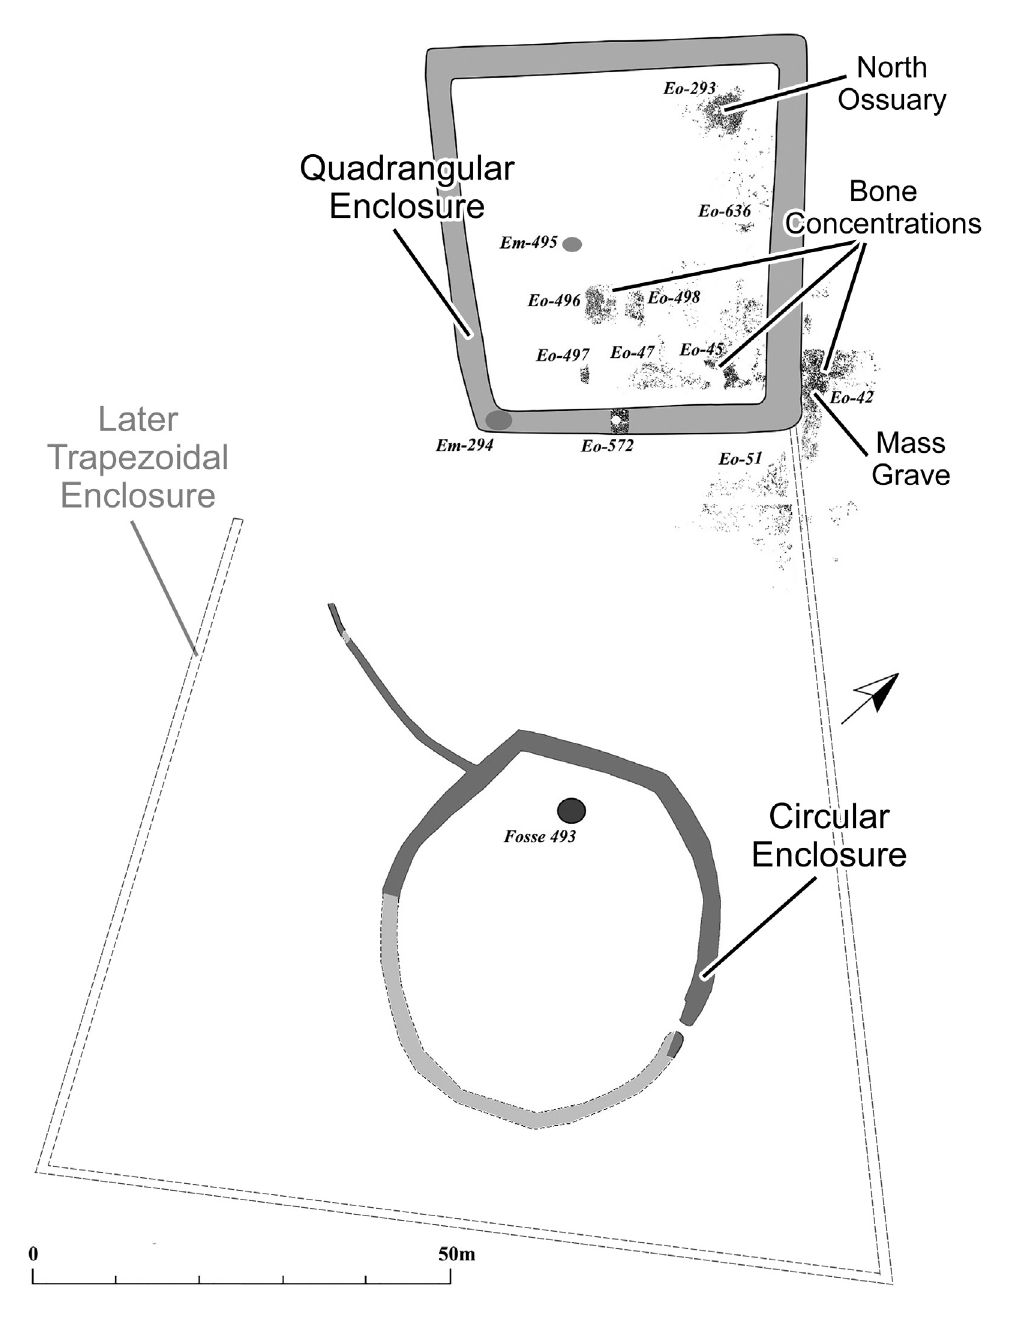
Figure 2: The La Tène enclosures at Ribemont (illustration: G. Fercoq du Leslay, Conseil Départemental de la